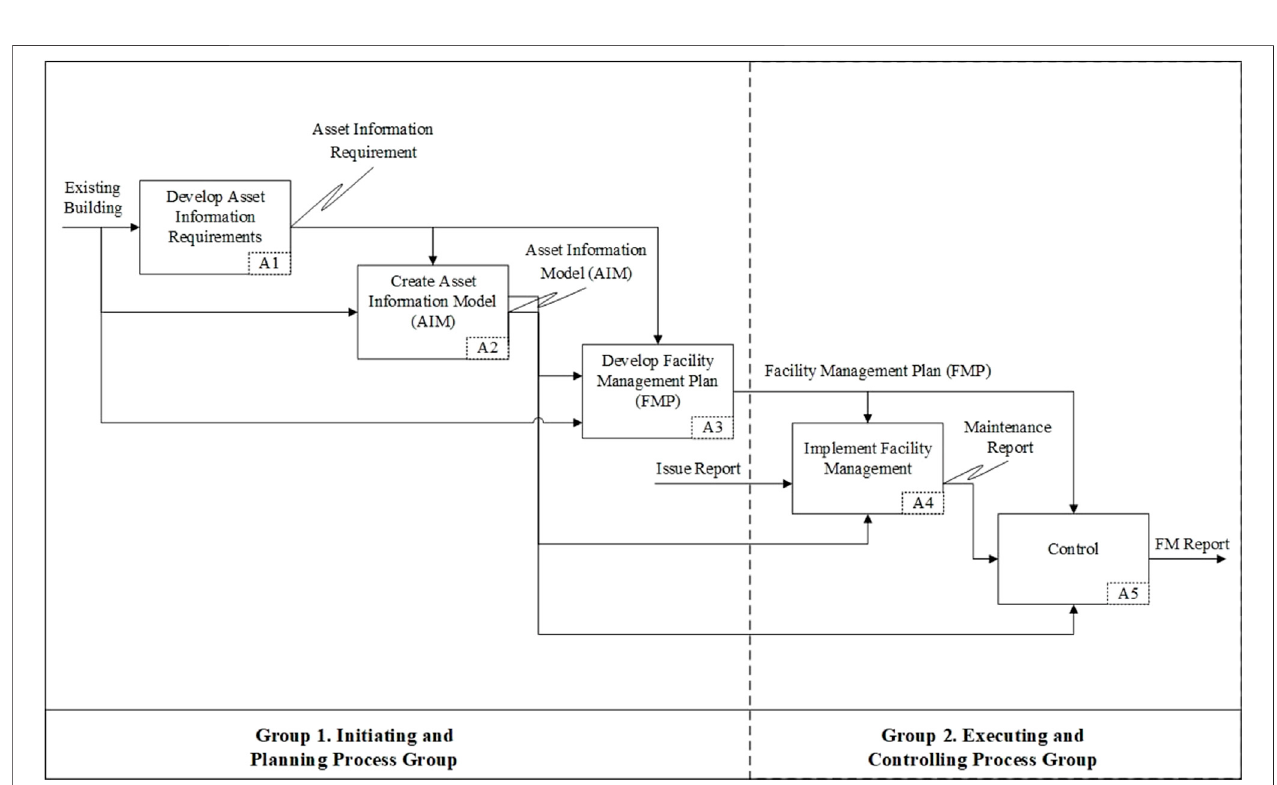
FIGURE 3 | Main process model of facility